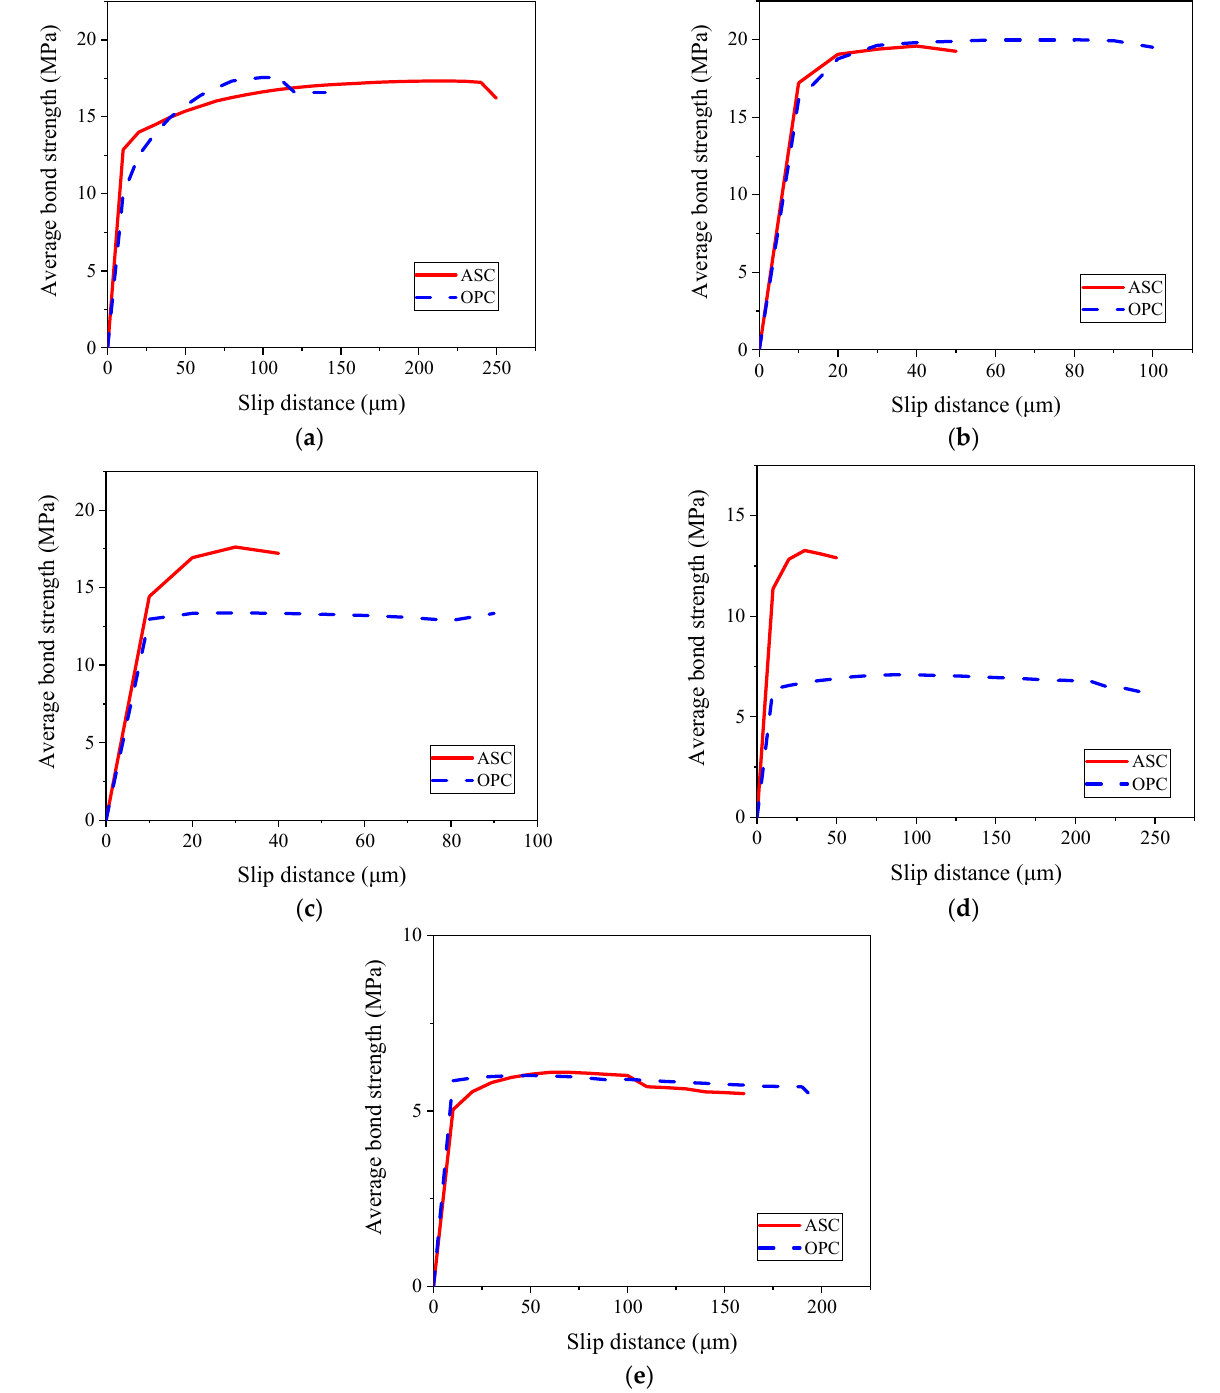
Figure 13. Comparison of bond–slip curves for ASC and OPC: ( a ) control; ( b ) 0.5% corrosion degree; ( c ) 1% corrosion degree; ( d ) 2% corrosion degree; and ( e ) 3% corrosion degree.